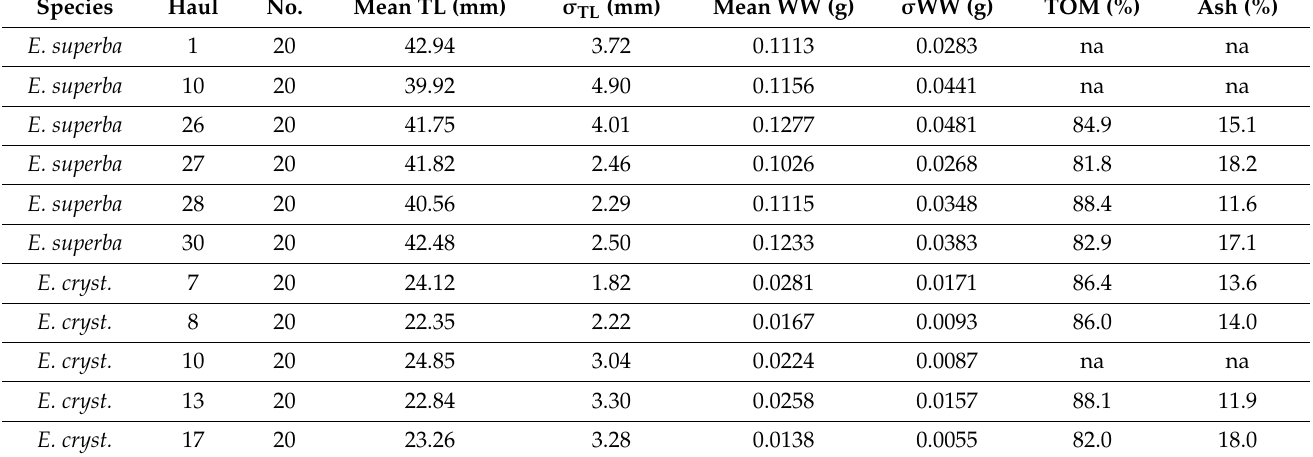
Table 2. Mean total length ± standard deviation of E. superba and E. crystallorophias specimens and percent content in Total Organic Matter (TOM) and ash relative to the wet weight of each